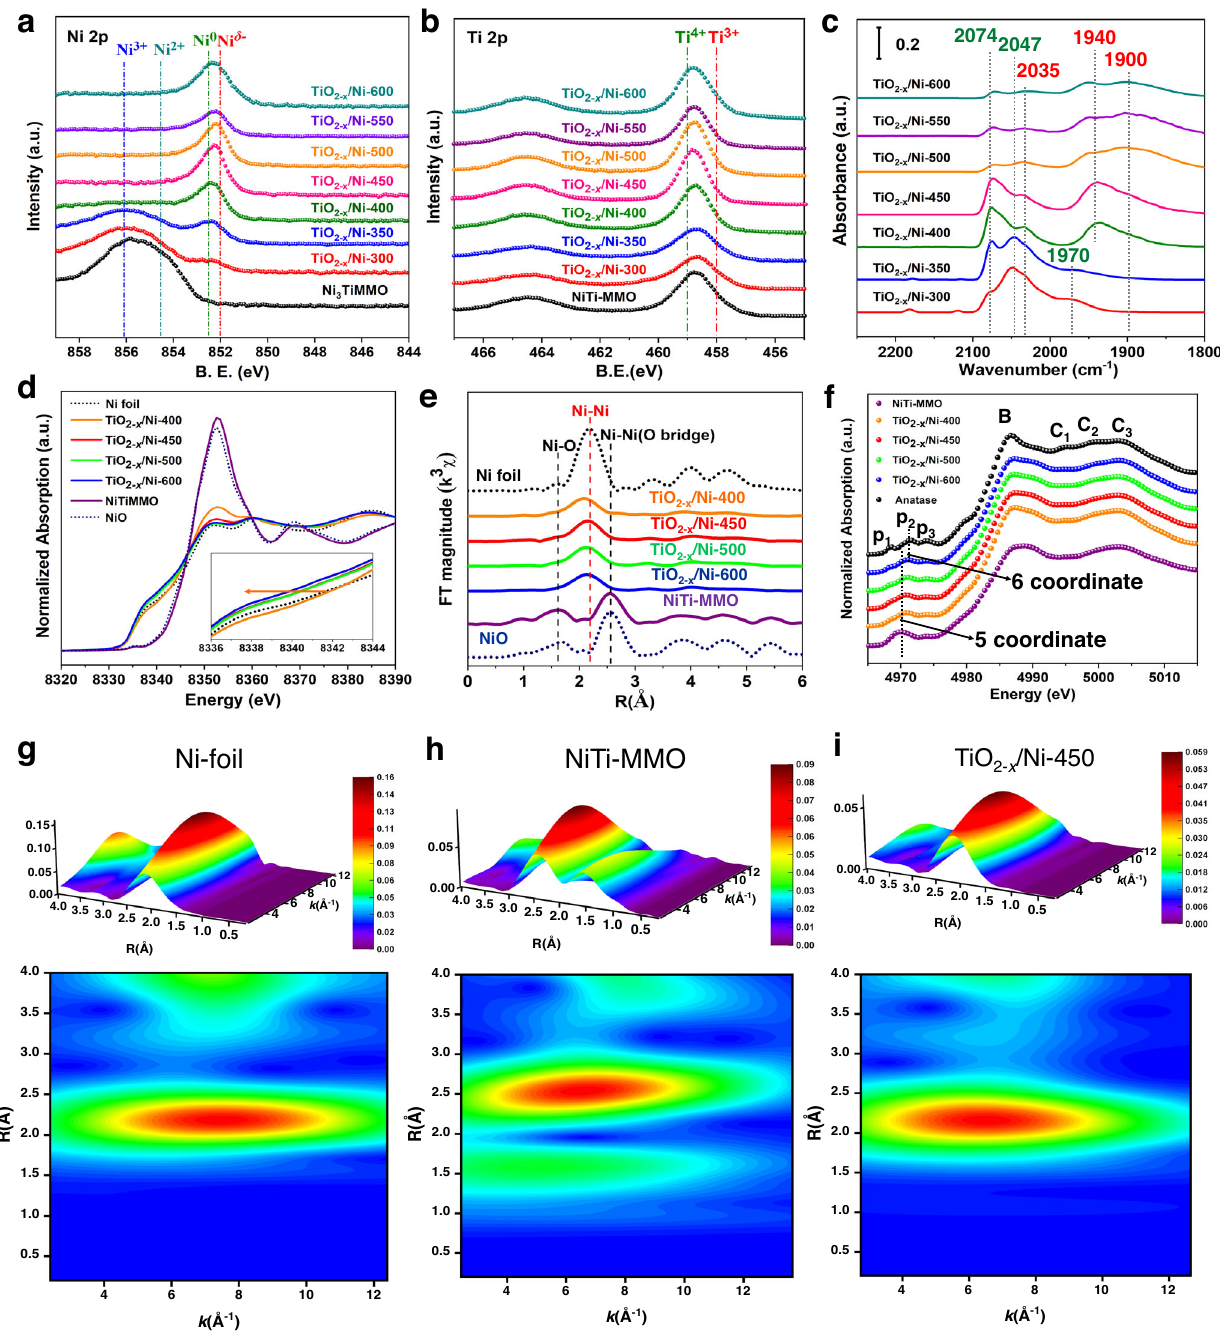
Fig.2|TherevelationofgeometricandelectronicstructureforvariousTiO 2 − x / Nicatalysts. QuasiinsituXPSspectraof( a )Ni2 p and( b )Ti2 p forvariousTiO 2 − x /Ni catalysts. c In situ CO-DRIFTS spectra of TiO 2 − x /Ni catalysts at room temperature. d The normalized Ni K -edge XANES spectra of various TiO 2 − x /Ni catalysts,